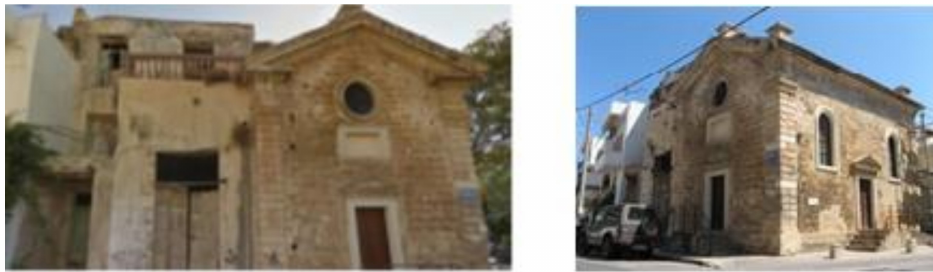
Figure 2. Front side of the temple showing the northern ( left ) and the southern ( right ) part.